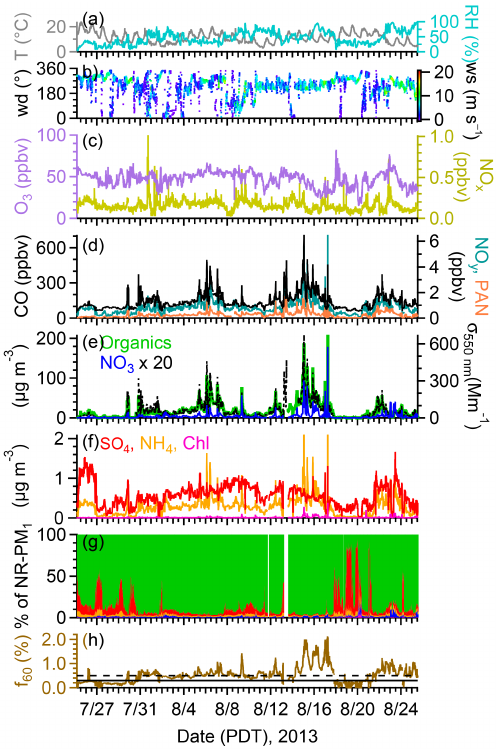
Figure 2. Time series of (a) temperature ( T ) and relative humid- ity (RH); (b) wind direction (WD) colored by wind speed (WS); (c) mixing ratios of O 3 and NO x ; (d) mixing ratios of CO, NO y , and PAN; (e, f) mass concentrations of NR-PM 1 species and σ 550nm in STP ( T = 273K, P = 1013 . 25hPa); (g) NR-PM 1 composition; and / OA). The solid and broken lines in panel (h) (h) f 60 ( = C 2 H 4 O + 2 indicate f 60 = 0 . 3% and f 60 = 0 . 5%,